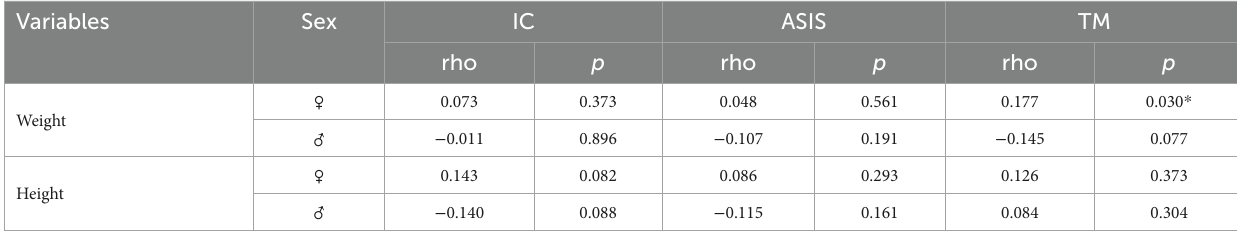
TABLE 6 Assessment of correlations between anthropometric variables and angle of asymmetry of selected pelvic girdle landmarks.